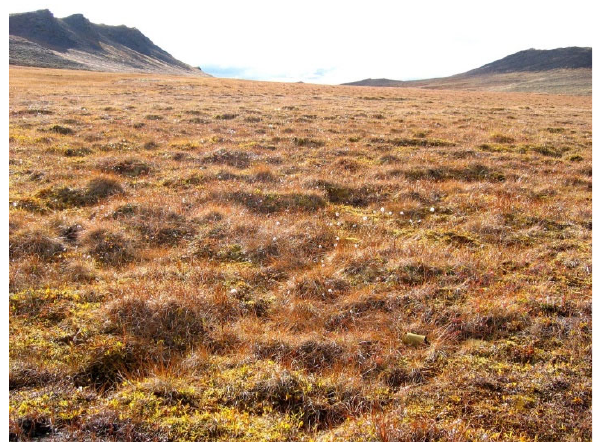
Figure 4. General view of monitoring site